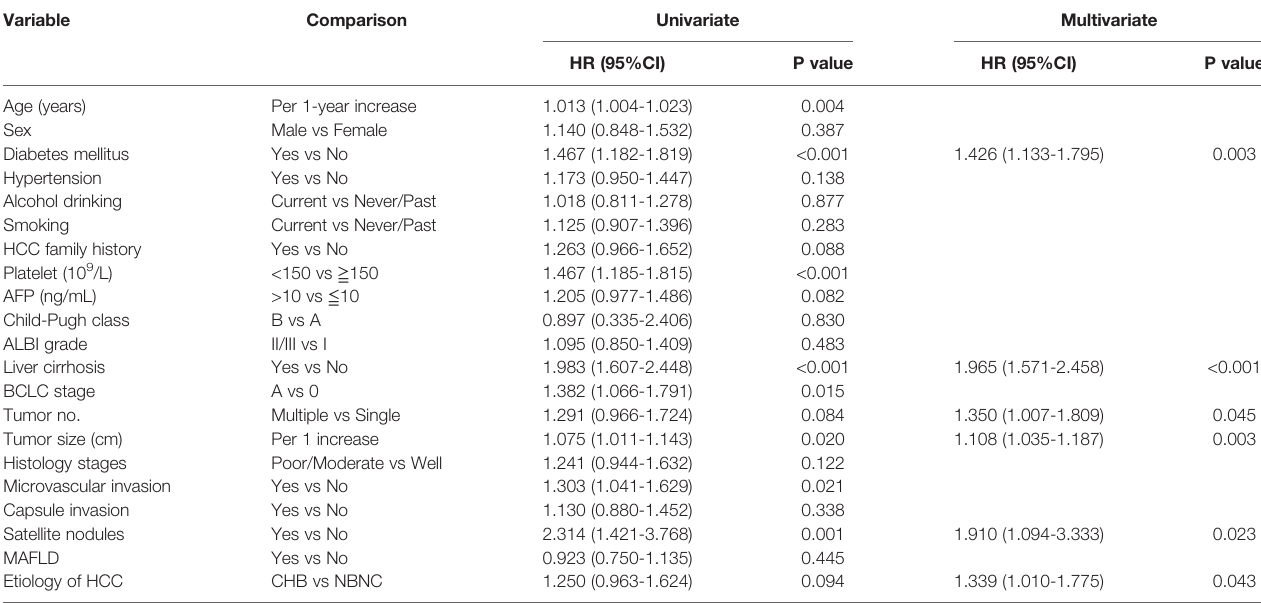
TABLE 3 | Prognostic factors associated with HCC